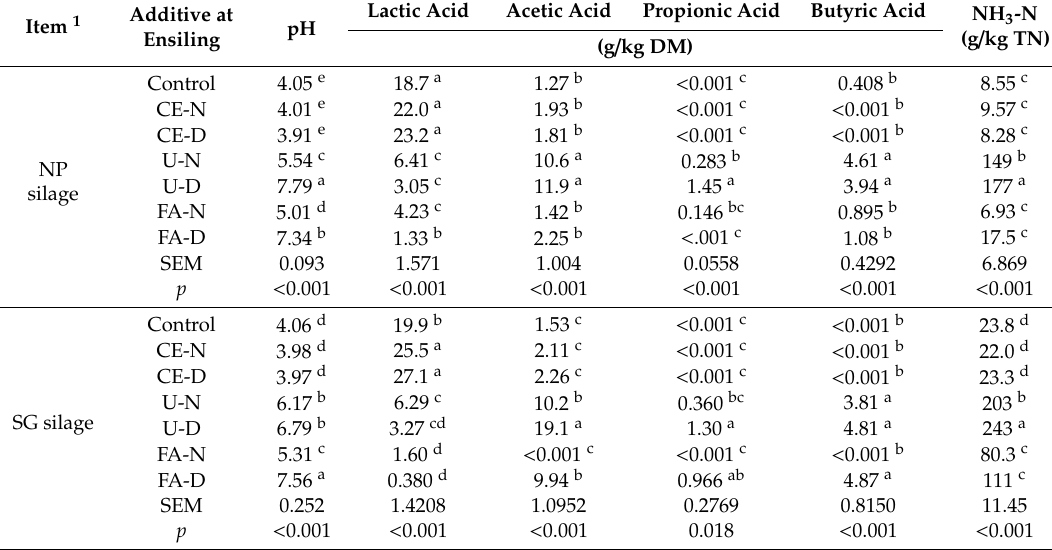
Table 3. Fermentation characteristics of silage safter 30 d of